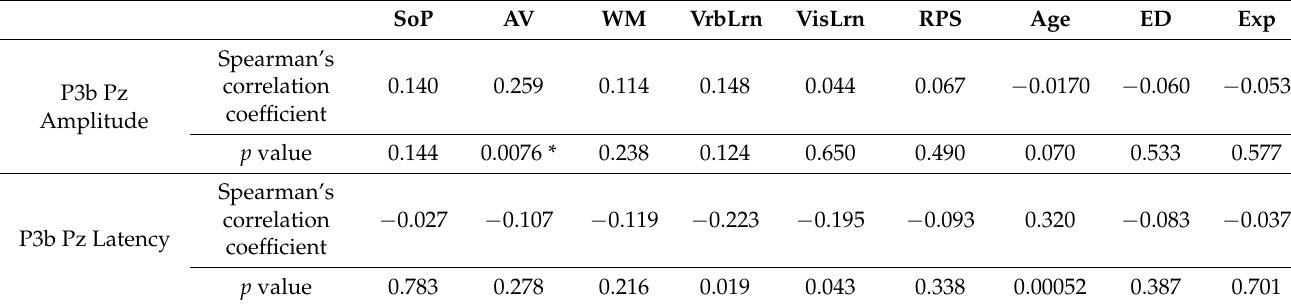
Table 3. Correlations between P3b and clinical/cognitive variables in SCZ.